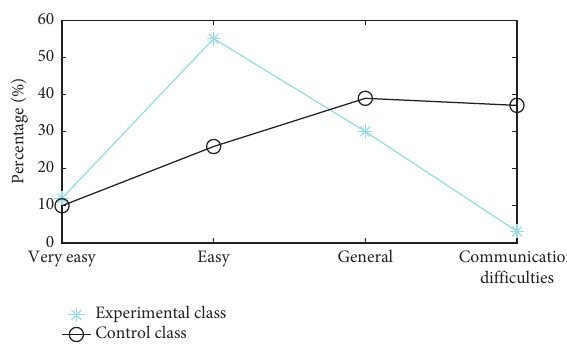
Figure 9: The degree of learner communication.